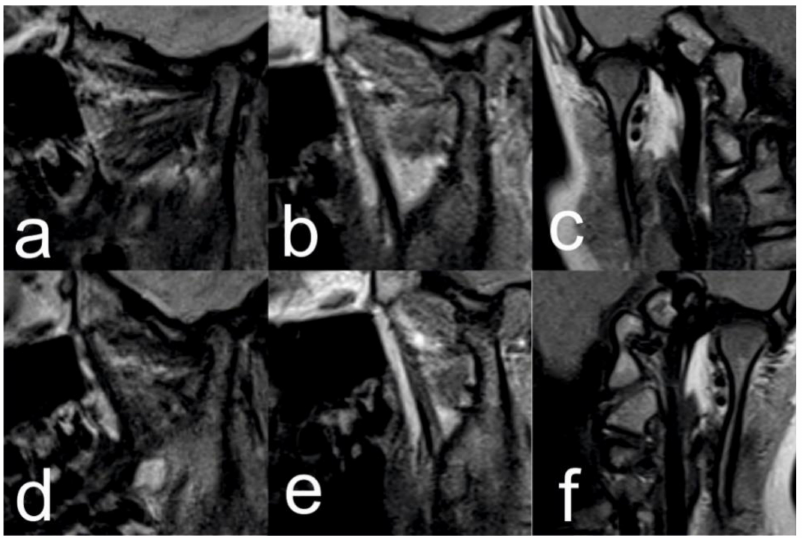
Figure 9. Pre-treatment TMJ MRI: Right TMJ sagittal view closed mouth ( a ), open mouth ( b ) and closed mouth coronal view ( c ); Left TMJ sagittal view closed mouth ( d ), open mouth ( e ), closed mouth coronal view ( f